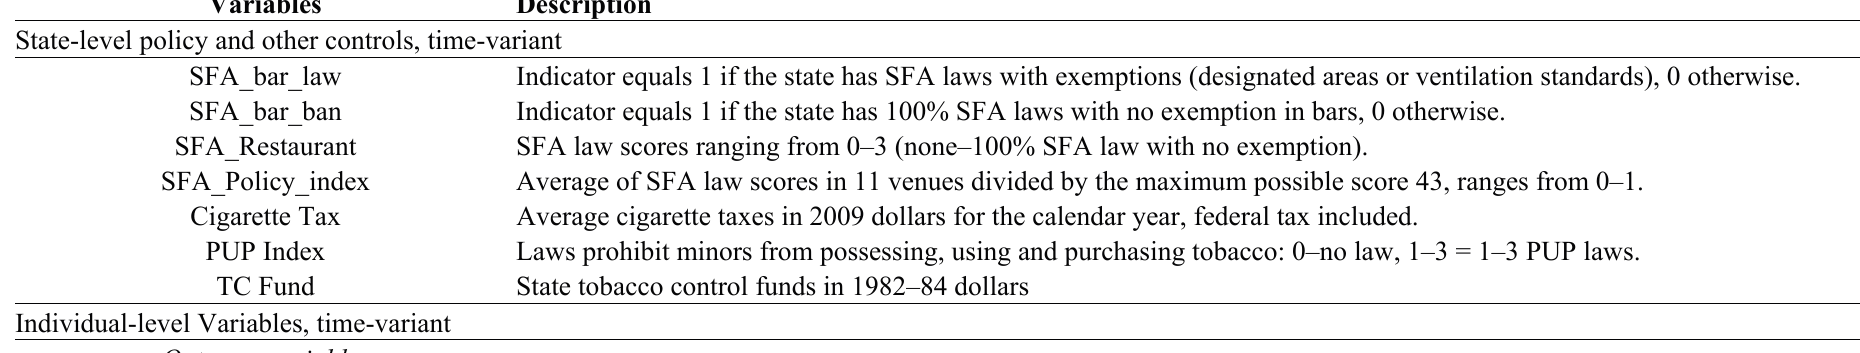
Table 1. Variable definition, NLSY97,